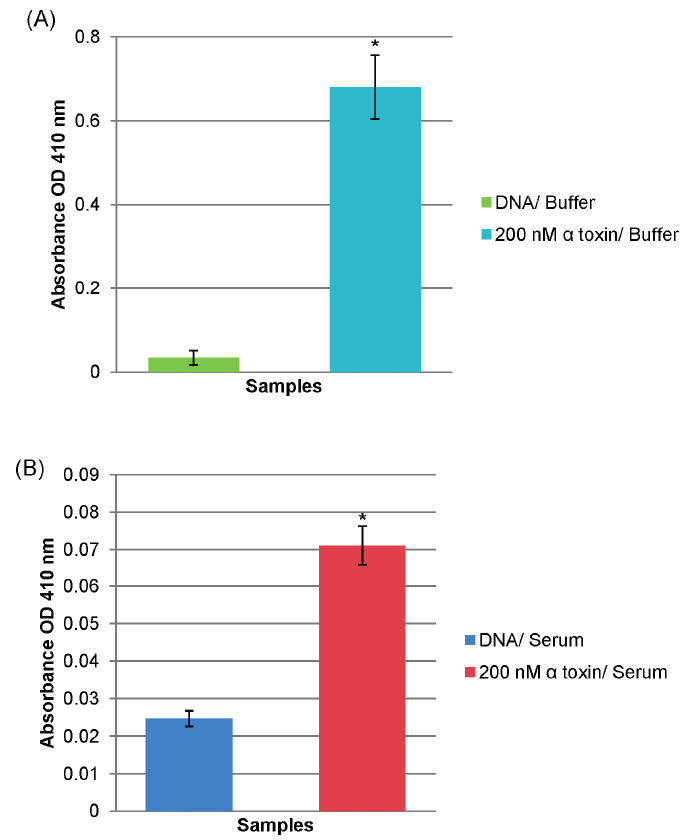
Figure 4. Detection of alpha toxin in modified ELISA assay. Data represent one modified sandwich ELISA with absorbance measured at 410 nm. Absorbance levels are subtracted from background levels of blank wells without immobilized DNA. ( A ) Statistical significance levels with respect to DNA with buffer background of p < 0.001 are designated by * ; and ( B ) Statistical significance levels with respect to human serum background of p < 0.001 are designated by * . Buffer: 1× selection buffer. Error bars are representative of ±1× standard